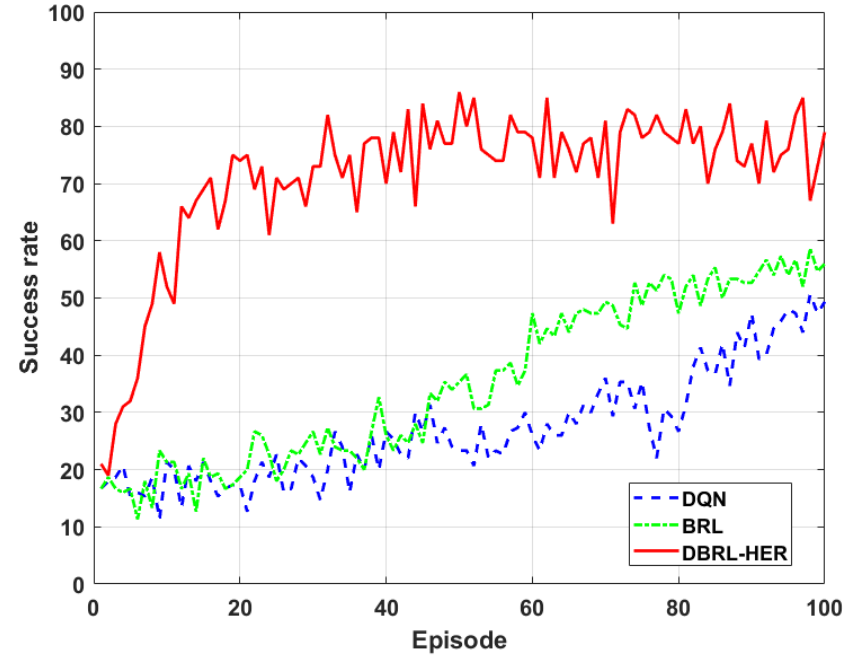
Figure 7. Collision avoidance success rate curves under 10 × 10 map.